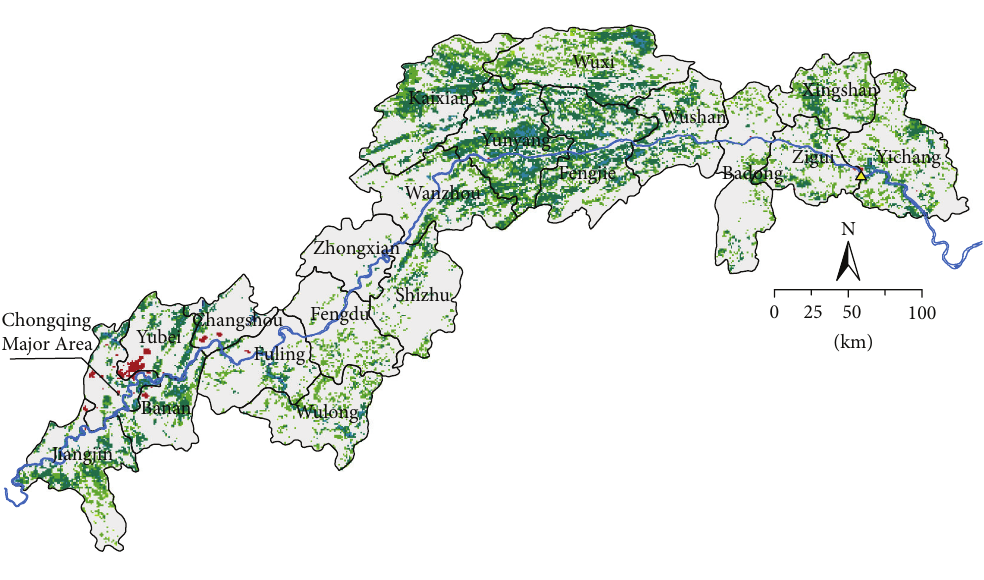
Figure 5: The slope of vegetation activity trend in